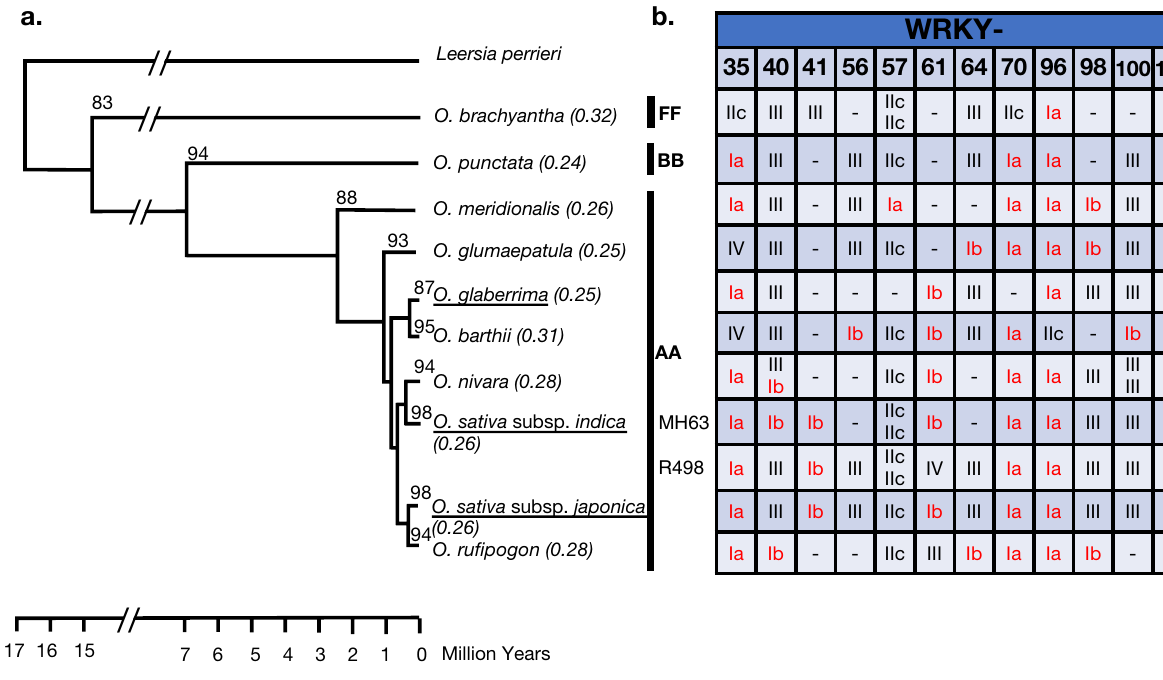
Figure 3. Evolution of the WRKY transcription factors and domain duplication events across Oryza genomes within the evolution timeline. ( a ) Oryza species phylogenetic tree with branches drawn to scale in evolutionary timeline 28 . The number of identified WRKYs is shown on each branch. The WRKY gene density (Average number of WRKYs/Mb of estimated genome size) is shown in parentheses, cultivated species identified in underlined font and genome types in bold font to the right. ( b ) WRKY genes with different domain structures across the Oryza genomes. Group classification is listed for each Oryza species. Classifications with two WRKY domains are in red font, double classification in a cell means gene occurs as paralog within the